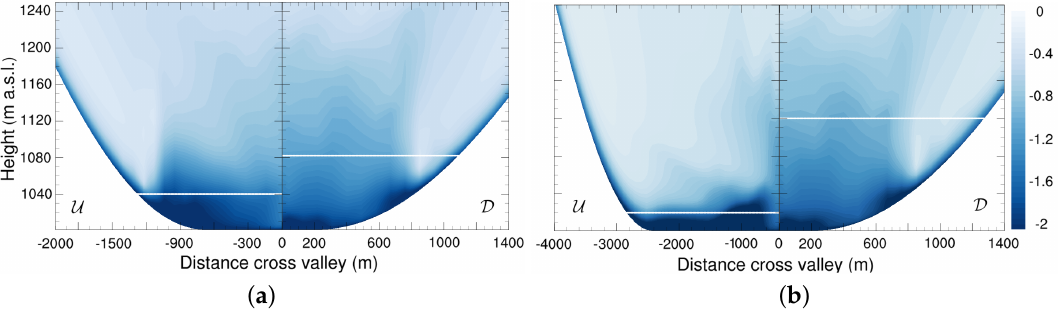
Figure 4. Vertical cross sections of the change in the potential temperature ( ∆ θ ) with respect to the initial condition averaged over 1 km along the y -direction and over 10 min about 90 min into the simulation for P1 ( a ), and P2 ( b ). Each frame is divided in two panels, the left panel corresponding to the exit of the upstream-valley U (10 km) and the right panel corresponding to the mid part of the downstream valley D (16 km). White lines represent an estimate of the CAP height at each